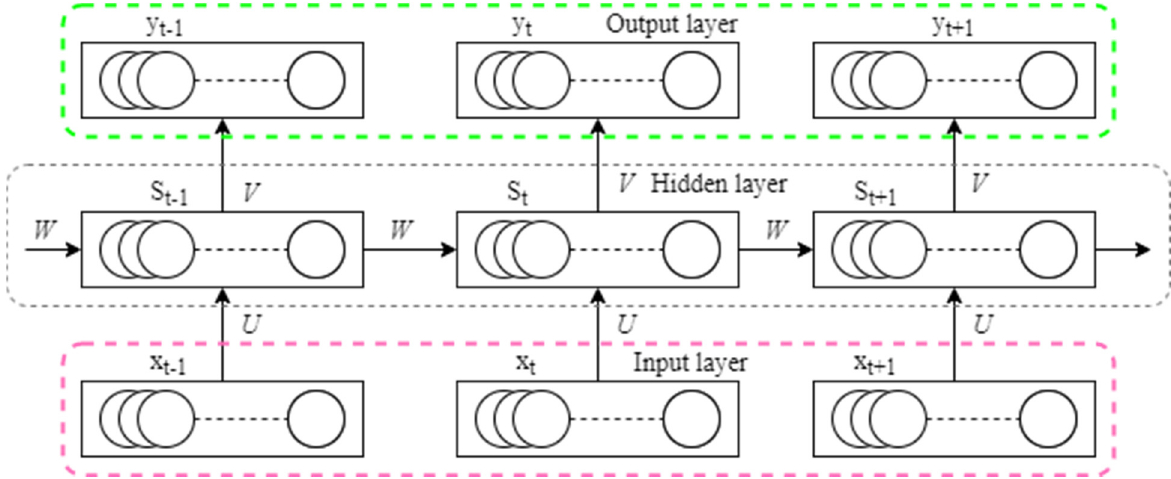
Figure 9. The basic structure of recurrent neural network (RNN).